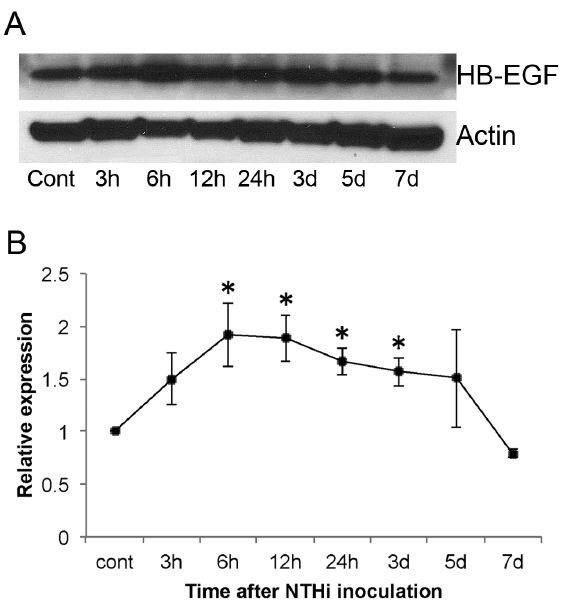
Figure 4. Western blot of HB-EGF in the ME mucosa. ( A ) Blot of HB-EGF expression in the ME at various postinoculation times. Total protein was equalized in all lanes and compared using an actin protein standard. ( B ) Quantitative analysis of HB-EGF shows a peak in relative expression at 6 h with continued upregulation through 3d, followed by a gradual decrease to control (uninoculated)